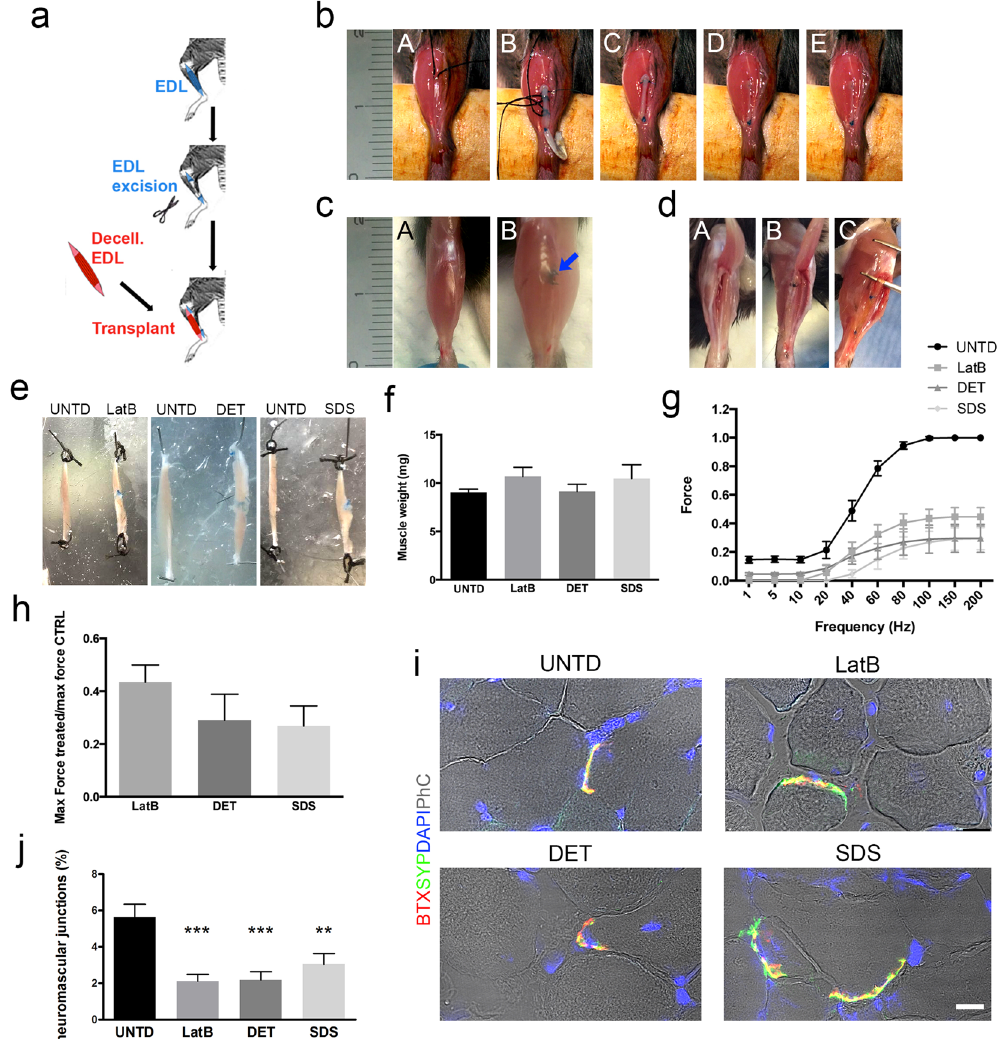
Figure 4. Implanted decellularised skeletal muscles allow functional muscle regeneration in a mouse model of VML. ( a ) Schematic diagram showing the surgical strategy used to generate VML model and implantation of acellular scaffolds. ( b ) Representative images showing the surgical procedure used for scaffold implantation. EDL muscle was exposed (A) and a first anastomosis was performed between the proximal edge of EDL muscle and the scaffold (B). The second anastomosis was carried out to the distal tendon of the EDL, then the scaffold length adapted to the implant size and the native EDL muscle resected between the two anastomosis (C). No-absorbable stitches are blue. Implant was relocated in the original anatomic position (D) and skin sutured (E). ( c ) Representative images showing macroscopic appearance of untreated contralateral (A) and implanted (B) mouse hindlimb 2 months after implantation. Arrow points at the proximal stitch used to anchor the scaffold to the native EDL muscle (blue). ( d ) Representative images showing macroscopic appearance of contralateral untreated EDL muscle (A), negative control muscle (B) and implanted scaffold (C) 2 months after implantation and after tibialis anterior dissection. ( e ) Representative images showing macroscopic appearance of contralateral untreated (UNTD, left) and LatB-, DET- and SDS-implanted EDL muscles (right) 2 months after implantation. ( f ) Mean weight of contralateral untreated EDL muscles (UNTD) and LatB-, DET- or SDS-implanted muscles two months after implantation. Data are shown as mean ± s.e.m.; n = 8-7, each group. No significant differences were observed among the groups. ( g ) Ex vivo force measurement of untreated EDL muscles, and LatB-, DET- and SDS-implants two months after implantation. Data are shown as mean ± s.e.m.; n = 6, each group. No significant differences were observed among the groups. ( h ) Ratio of the maximal force generated ex-vivo from regenerated implants (LatB, DET and SDS) and contralateral untreated EDL muscles two months after implantation. Data are shown as mean ± s.e.m.; n = 6, each group. No significant differences were observed among the groups. ( i ) Representative confocal images of cross-sections from contralateral untreated EDL muscles, and LatB-, DET- and SDS-implanted scaffolds stained with bungarotoxin (BTX - red) and synaptophysin (SYP - green) two months after implantation. Nuclei were stained with dapi (blue) and phase contrast (PhC) is shown to highlight staining localization (scale bar: 10 µ m). ( j ) Percentage of neuromuscular junctions in untreated and implanted scaffolds calculated as percentage of SYP/BTX double-positive cells. ** P < 0.01; *** P < 0.001 each decellularised sample compared to untreated